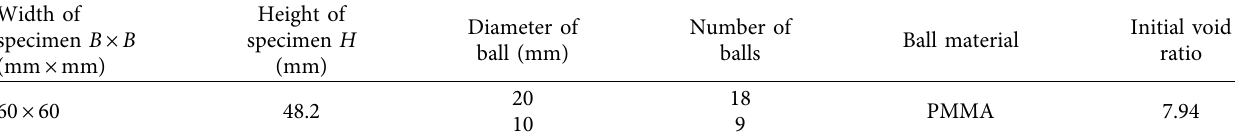
� 3 ( B � 120mm, d � 40mm). (b) R d